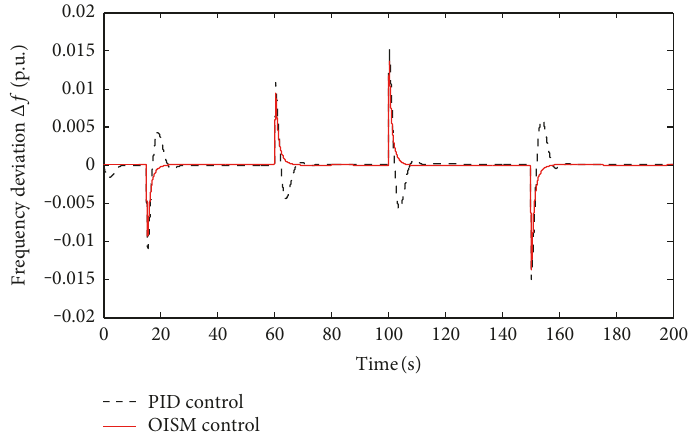
Figure 9: The frequency performance without power output